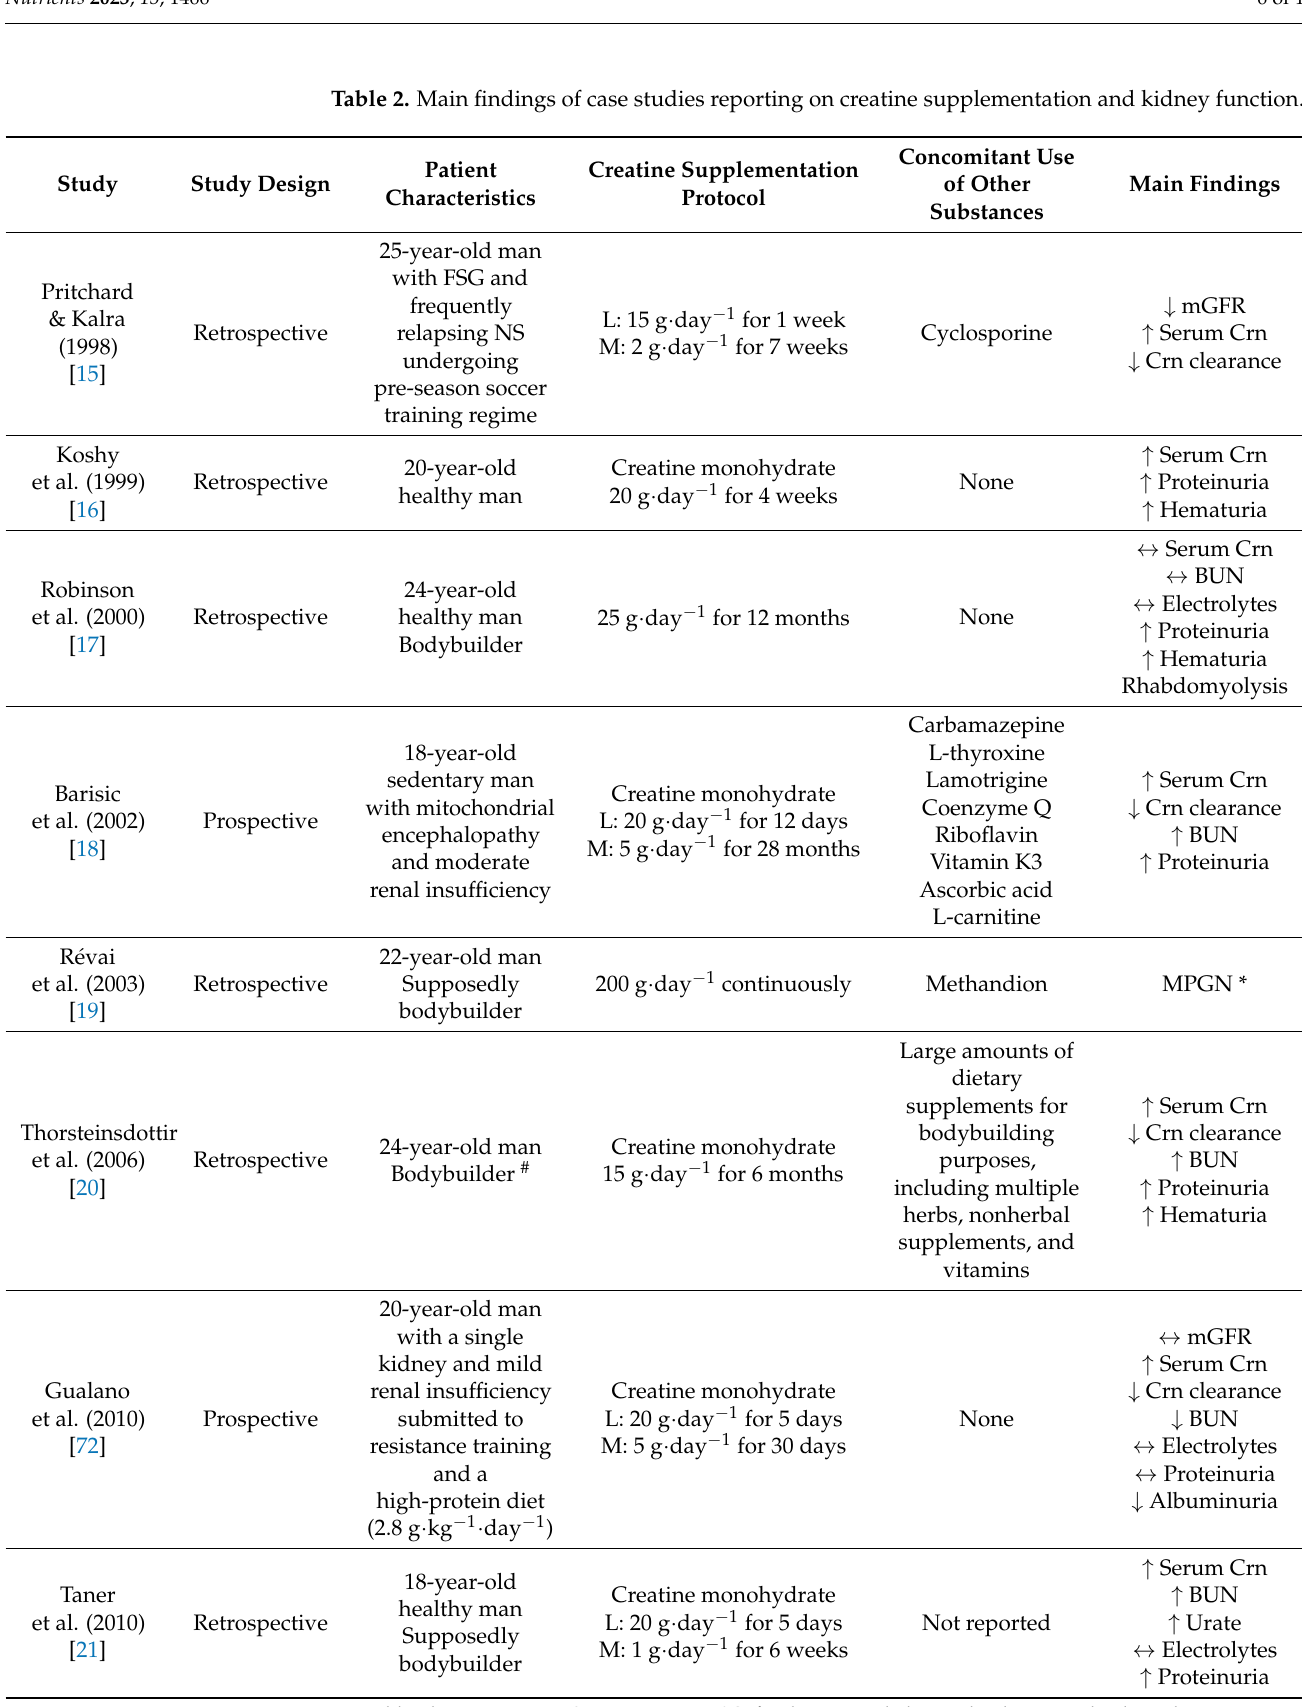
Table 2. Main findings of case studies reporting on creatine supplementation and kidney